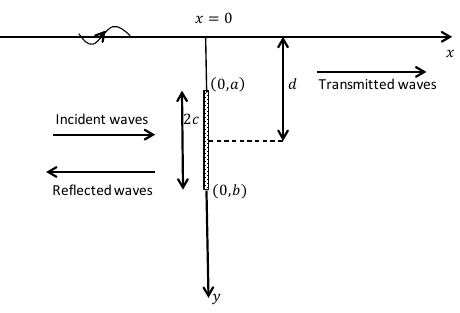
𝑦𝑦 Figure 1. Schematic diagram of permeable vertical